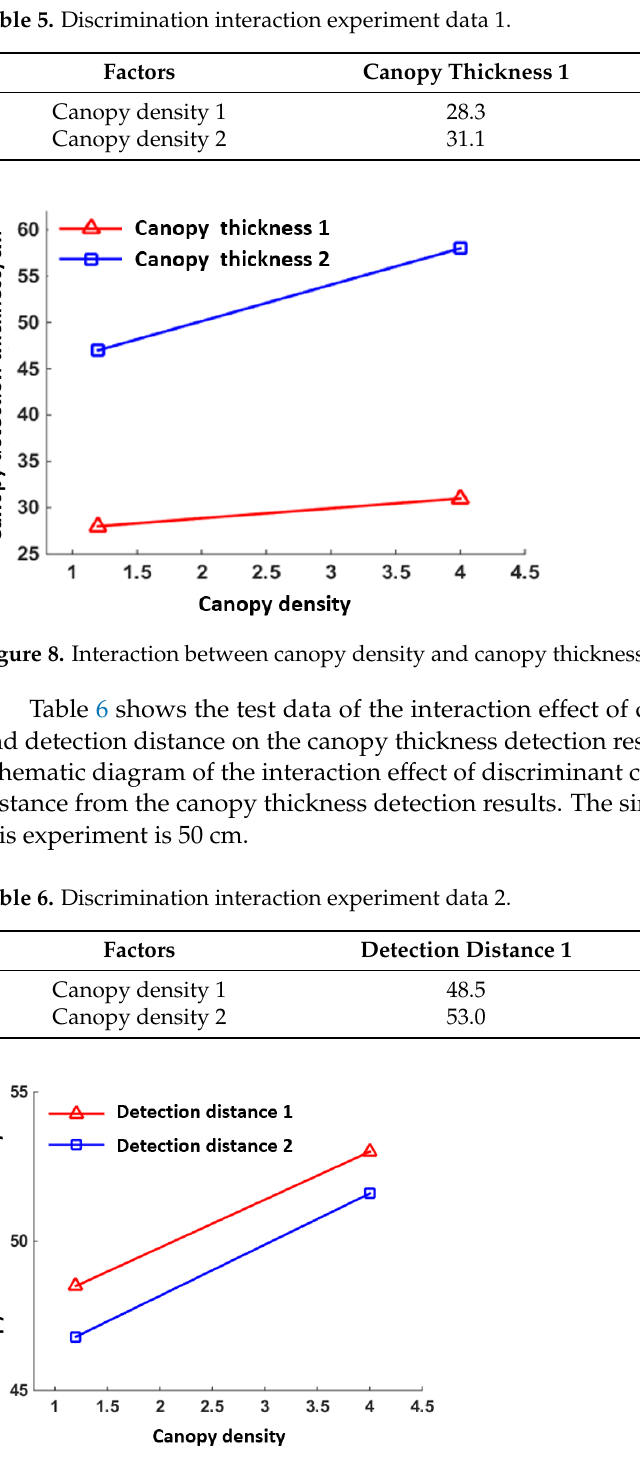
Figure 9. Diagram of the interaction between detection distance and canopy density.